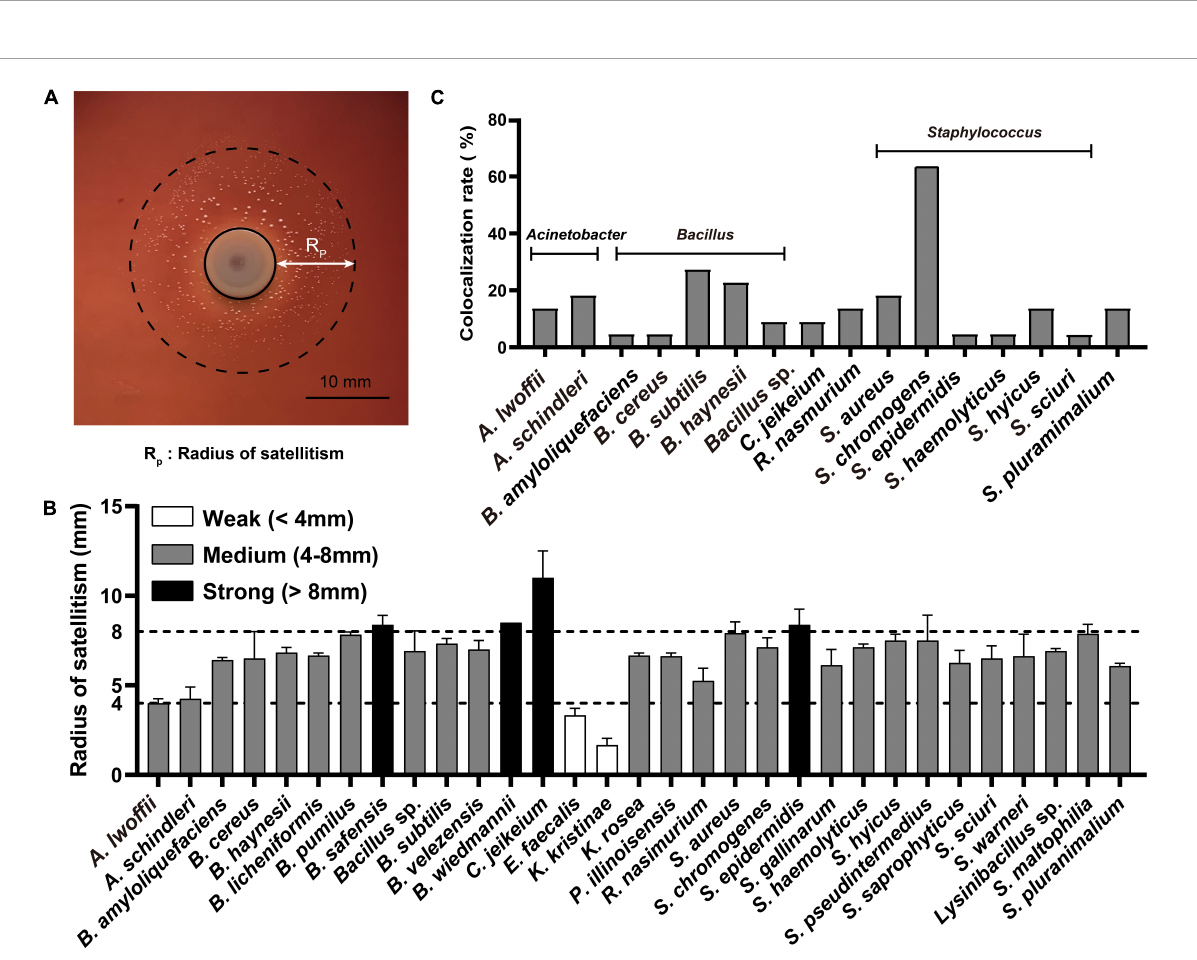
FIGURE2 Commensals facilitated the growth of A. paragallinarum . (A) Representative image of the satellitism that commensal bacterium was surrounded by A. paragallinarum. (B) The satellitism profiles of commensals from IC chicken. (C) The colocalization profiles of commensals with strong growth-promoting effect on A. paragallinarum . The full names of genera were replaced by the abbreviation in this figure, and the full name of genera was listed in Supplementary Table 1